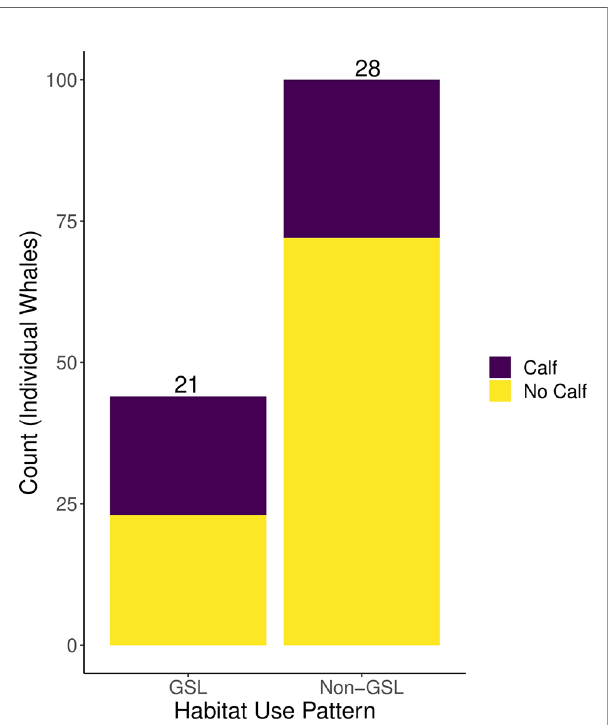
FIGURE 5 | The proportions of individuals' observed habitat use patterns relative to the habitat use patterns of their mothers. “ GSL ” indicates individuals that used the Gulf of St. Lawrence at least once during the years 2015 – 2019. “ Non-GSL ” indicates individuals that were not seen in the Gulf of St. Lawrence during the same period. The numbers within the bars are the total number of offspring represented by the respective bar/color